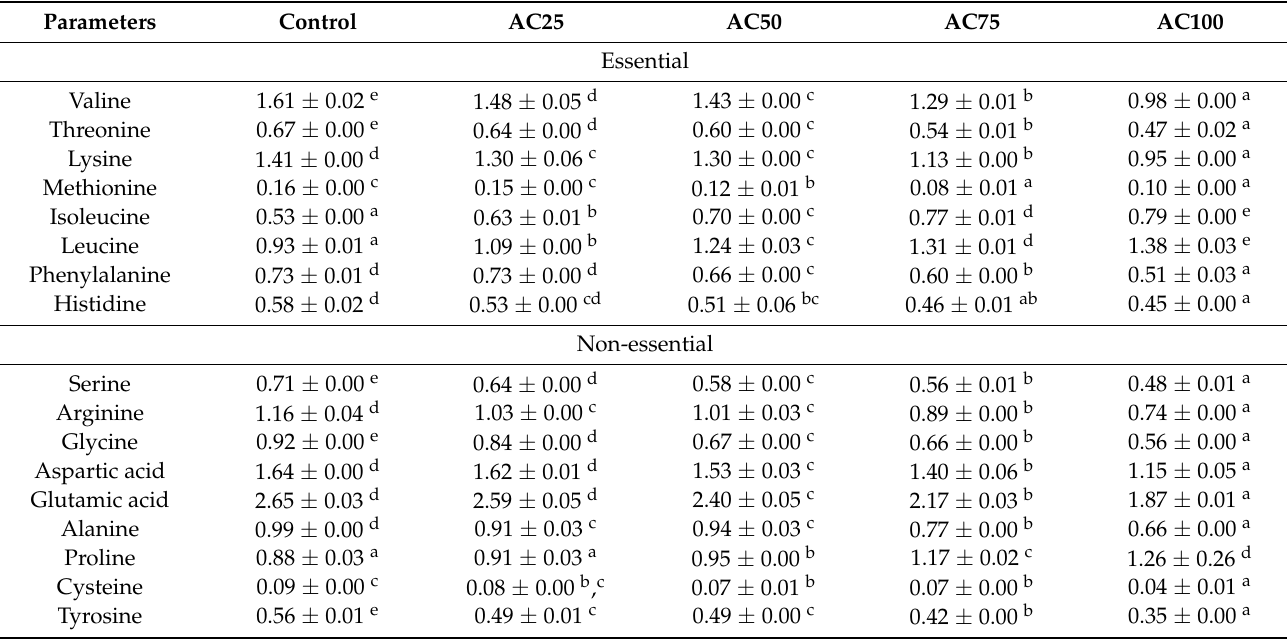
Table 4. Free amino acids (expressed as g/100 g of sausage) profile of sausages with substitution of pork fat by Auricularia cornea